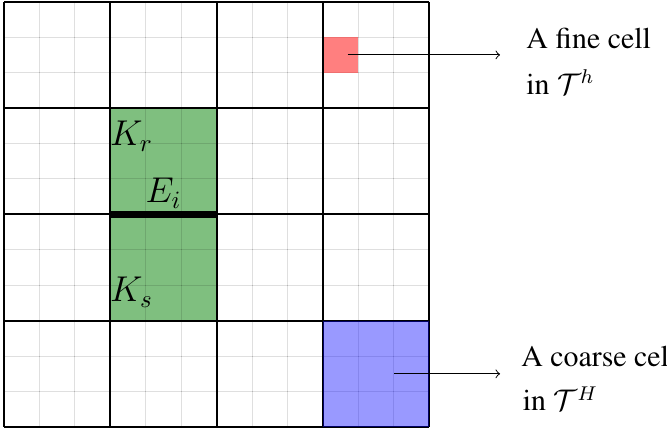
Figure 1. An illustration of a coarse neighborhood ω edge E i